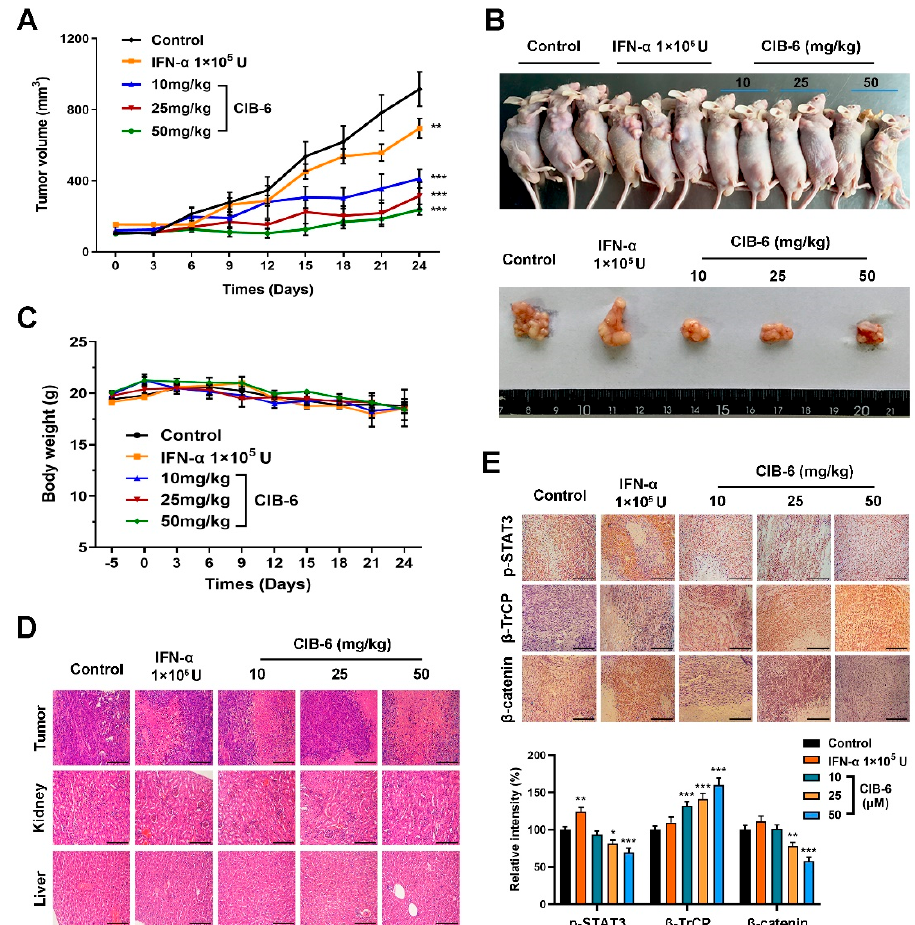
Figure 6. CIB-6 suppresses HCC tumor growth in vivo. ( A ) Tumor volumes were measured every three days with a caliper ( n = 8, ** p < 0.01, *** p < 0.001 as compared with control). ( B ) Tumors were excised from mice at the termination of the experiment. Representative images of mice with xenograft tumors were captured with a camera. ( C ) Body weights of mice were measured every three days. ( D ) Hematoxylin–Eosin (H&E) staining of tumor tissues and major organs (liver and kidney). A magnification of ×100 was employed. ( E ) Immunohistochemical analyses of p-STAT3, β -catenin, and β -TrCP expression (×100). The relative intensity of the indicated proteins was semi-quantified using the ImageJ software (* p < 0.05, ** p < 0.01, *** p < 0.001 as compared with control).